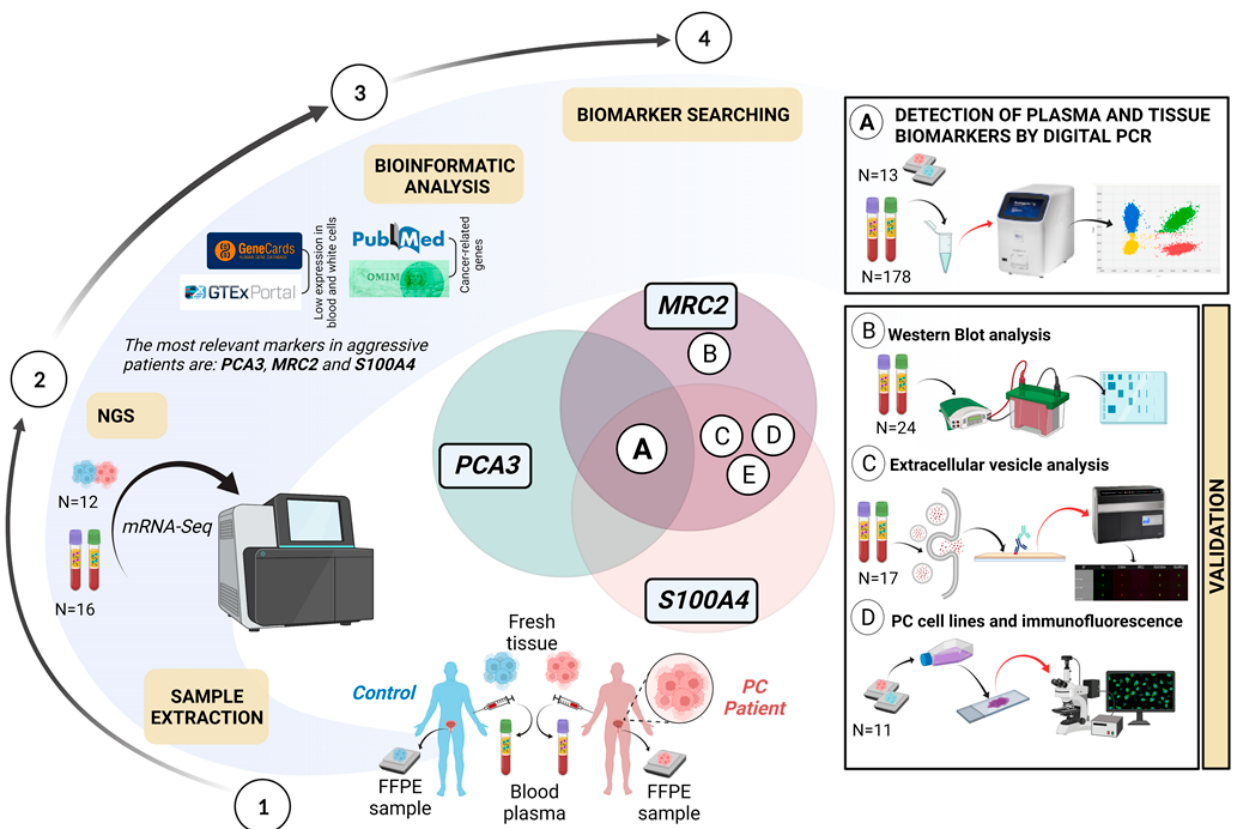
Figure 1. Design and methodological patterns of the present study. It shows how several methodologies and determinations were conducted to validate the results. (A) digital PCR analysis in tumor tissues and confirmed by a pathologist in healthy tissue; (B) MRC2 proteins analysis in plasma; (C) microvesicles selection and dyeing in MRC2 and S100A4 for visualizing in cytometry; (D) immunofluorescence in cell lines and tissues for MRC2 and S100A4 ; (E) immunohistochemistry in PC tissue ( MRC2 and S100A4 ). Previously, markers were selected by NGS analysis (2) by using filters obtained from different resources.